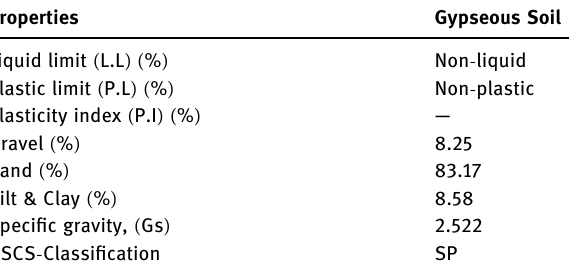
Table 1: Engineering properties of the soil Properties